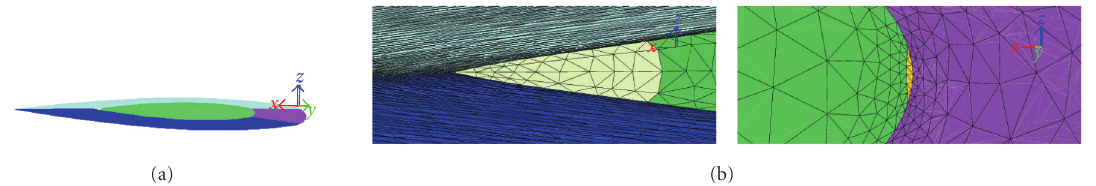
Figure 23: Patches of the reconstructed ONERA M6 wing mesh—(a) side view, (b) detail of the tail (left) and tip (right).